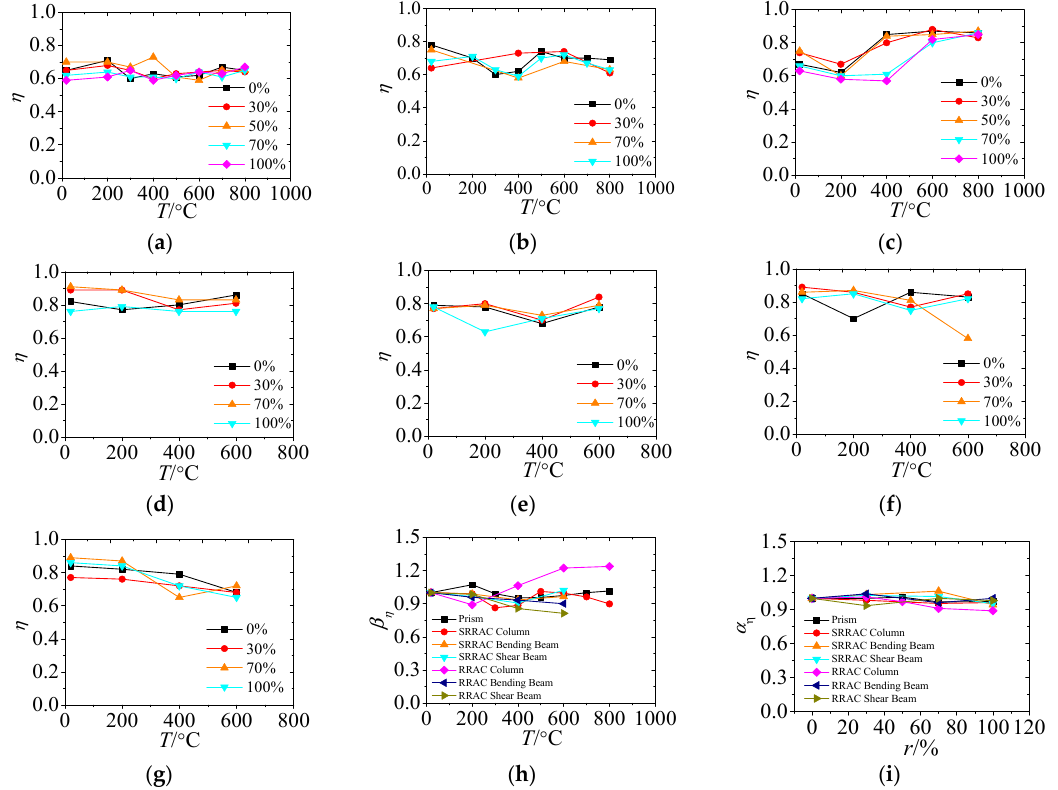
Figure 18. Influence of variation parameters on energy dissipation. ( a ) Prism; ( b ) SRRAC column; ( c ) RRAC column; ( d ) SRRAC bending beam; ( e ) SRRAC shear beam; ( f ) RRAC bending beam; ( g ) RRAC shear beam; ( h ) Temperature; ( i ) Replacement percentage.